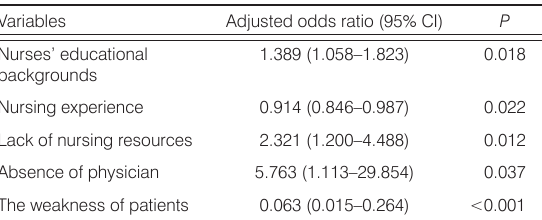
Table 2. Variables independently associated with early mobility implementation on logistic regression analysis in the study of Chinese intensive care units. Note: For models assessing nurses’ educational backgrounds, nursing experience, lack of nursing resources, the weakness of patients, with the Hosmer–Lemeshow test for goodness of fit test, R 2 =81.010, df =18, and P